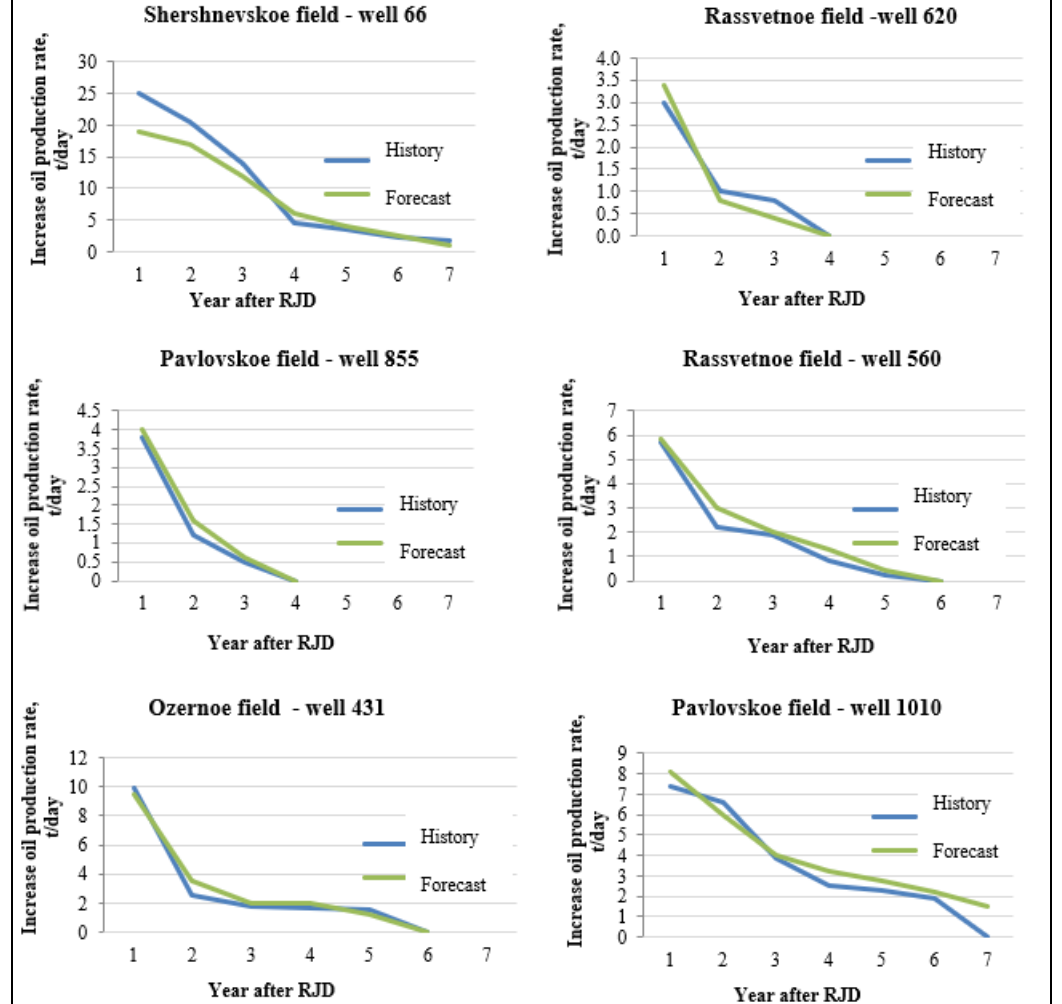
Figure 6. Comparison of the forecast using the developed method to the actual average daily oil production increment data by years. Table 5. Statistical measures of the proposed forecasting method.